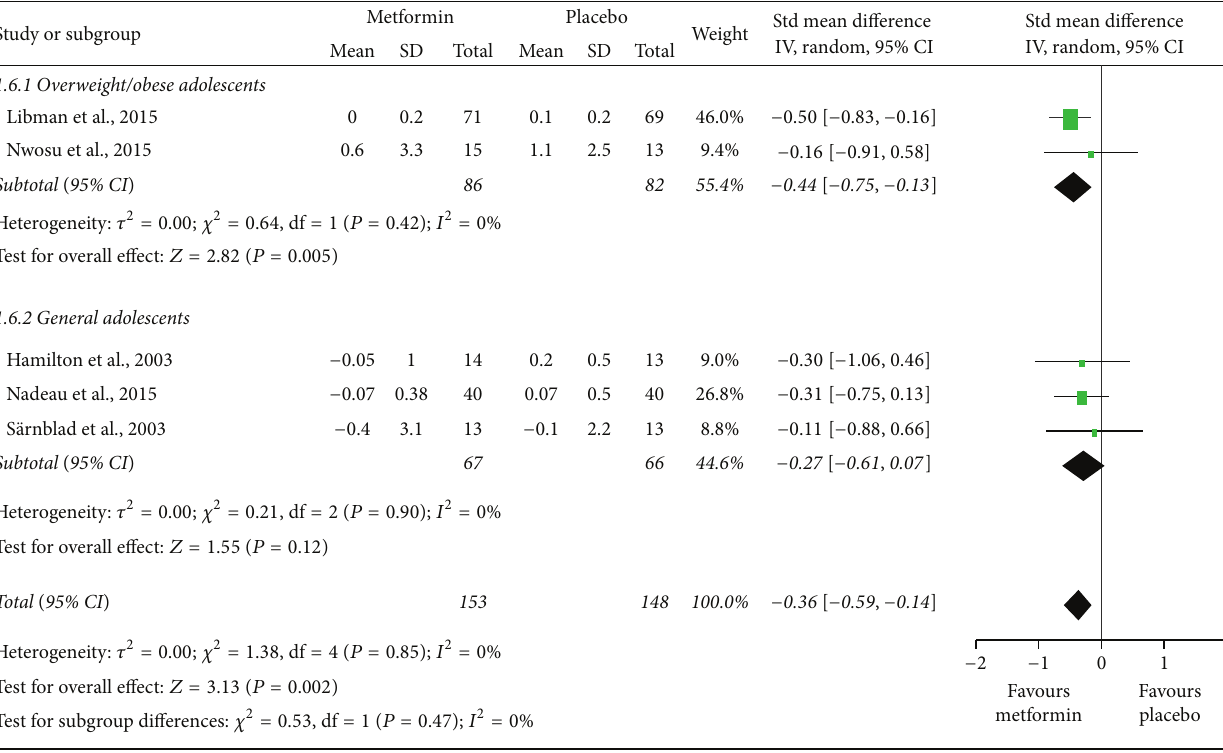
Figure 4: Standardized mean differences in changes in body mass index (BMI) from baseline to study termination between patients who received adjunctive metformin therapy or placebo in adolescents with type 1 diabetes mellitus. CI: confidence interval; IV: inverse variance.